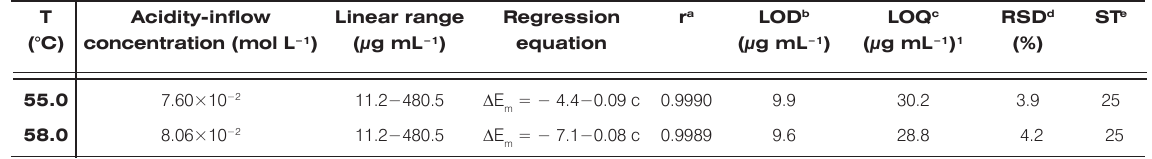
Table 1. Features of the calibration plots and analytical figures of merit for the determination of PX at different temperatures and acidities. T